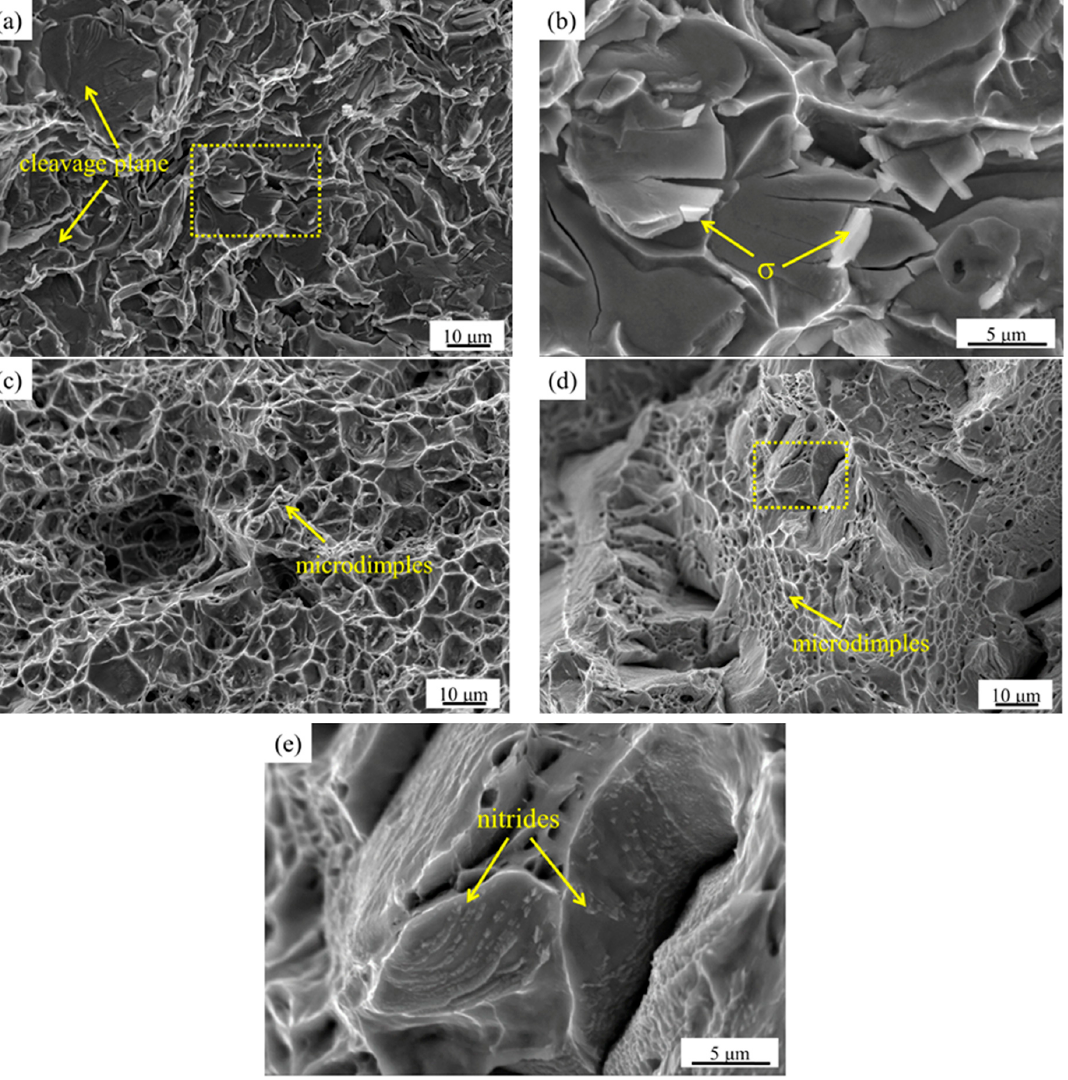
Figure 8. The SEM images of tensile fracture of the specimens after solution treatment at: ( a ) 1040 °C; ( b ) enlarged images of square frame area in ( a ); ( c ) 1100 °C; ( d ) 1200 °C; ( e ) enlarged images of ( b ) enlarged images of square frame area in ( a ); ( c ) 1100 ◦ C; ( d ) 1200 ◦ C; ( e ) enlarged images of square square frame area in ( d ). frame area in ( d